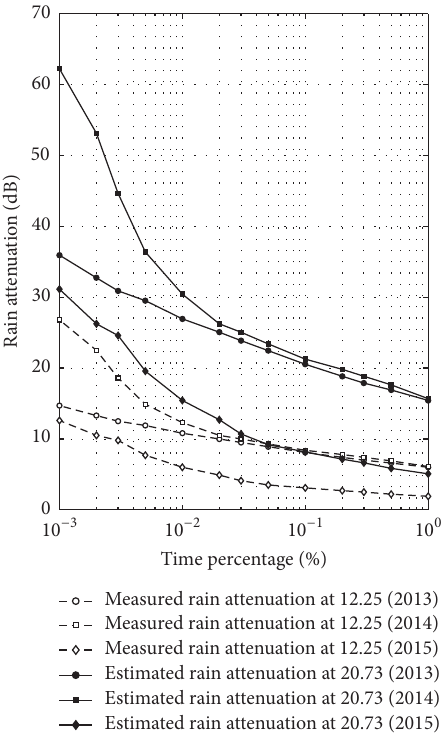
Figure11:Cumulativedistributionofrainattenuationobtainedafter frequency scaling for 20.73 GHz [20].